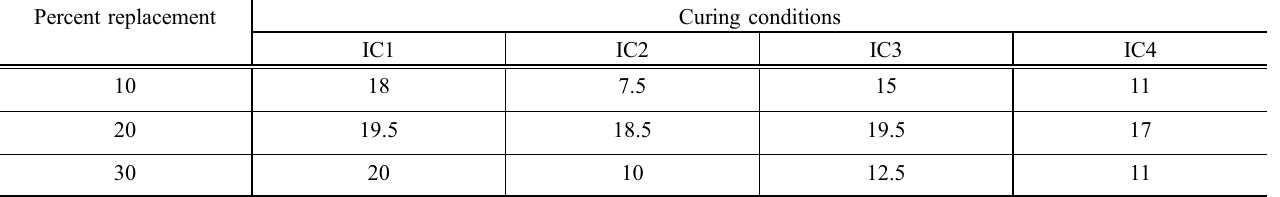
Table 4 Percent increase in modulus of elasticity with respect to control samples under similar curing conditions (w/c ratio 0.4). Percent replacement